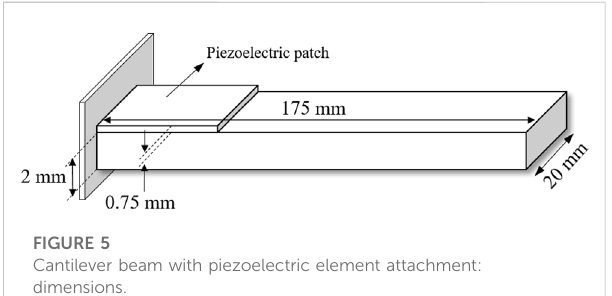
Cantilever beam with piezoelectric element attachment: dimensions.